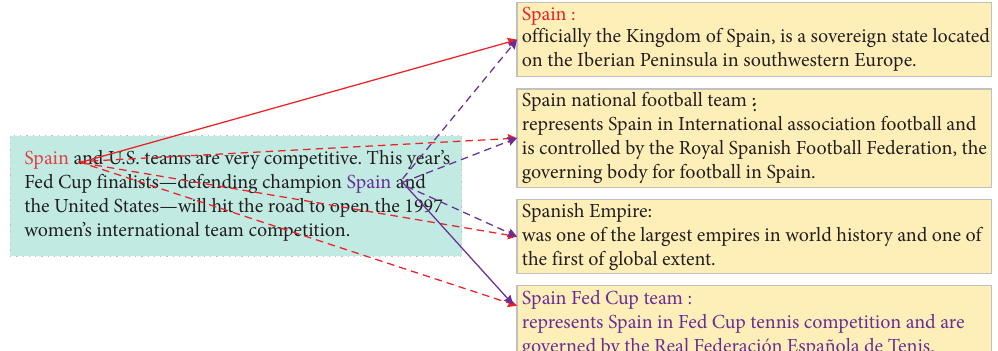
governed by the Real Federación Española de Tenis. Figure 1: Illustration of mentions in the snippet and their candidate entities in the knowledge base. Solid lines point to the correct target entities corresponding to the mentions and to the descriptions of these correct target